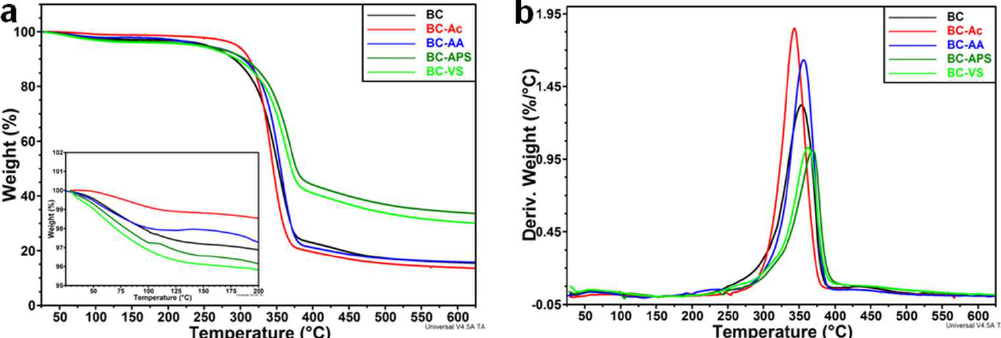
Figure 8. TGA ( a ) and DTG ( b ) curves of treated and original BC, inset—initial degradation step.